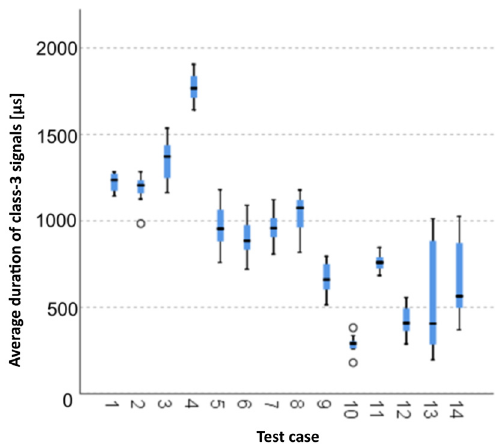
Figure 10. Graphic presentation of the Kruskal–Wallis test results for independent samples: average duration of class-3 signals.